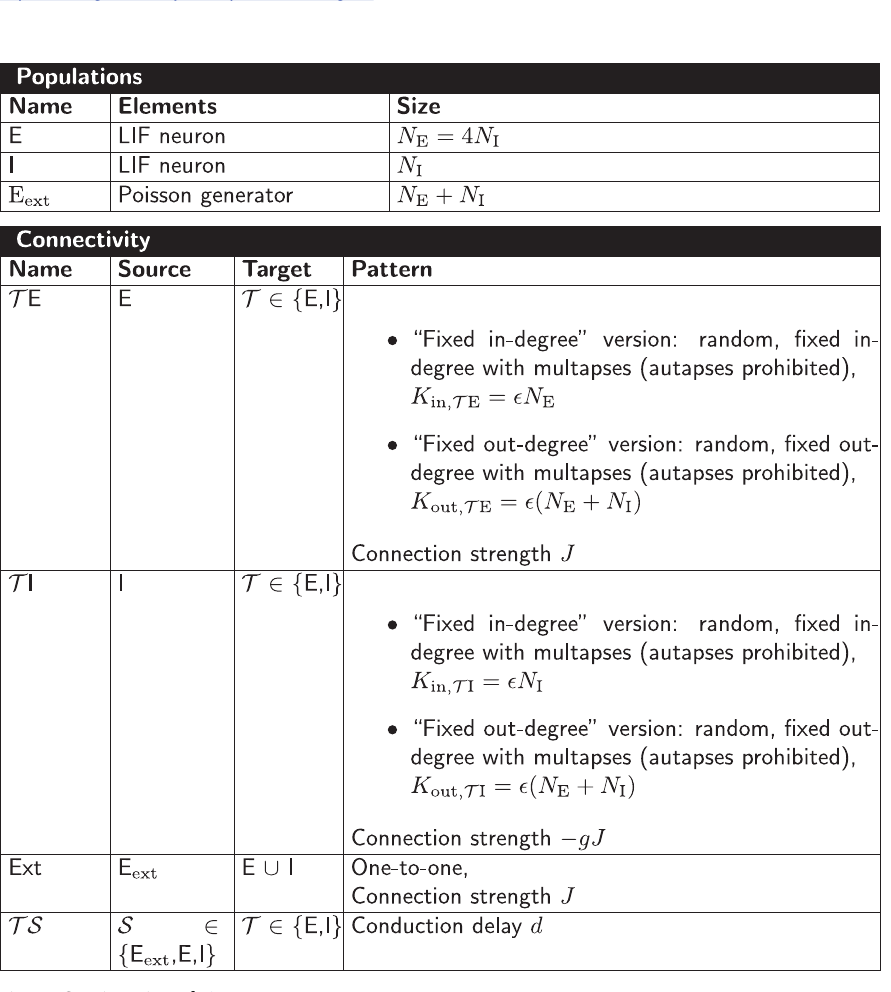
Fig 13. Continuation of Fig 12.